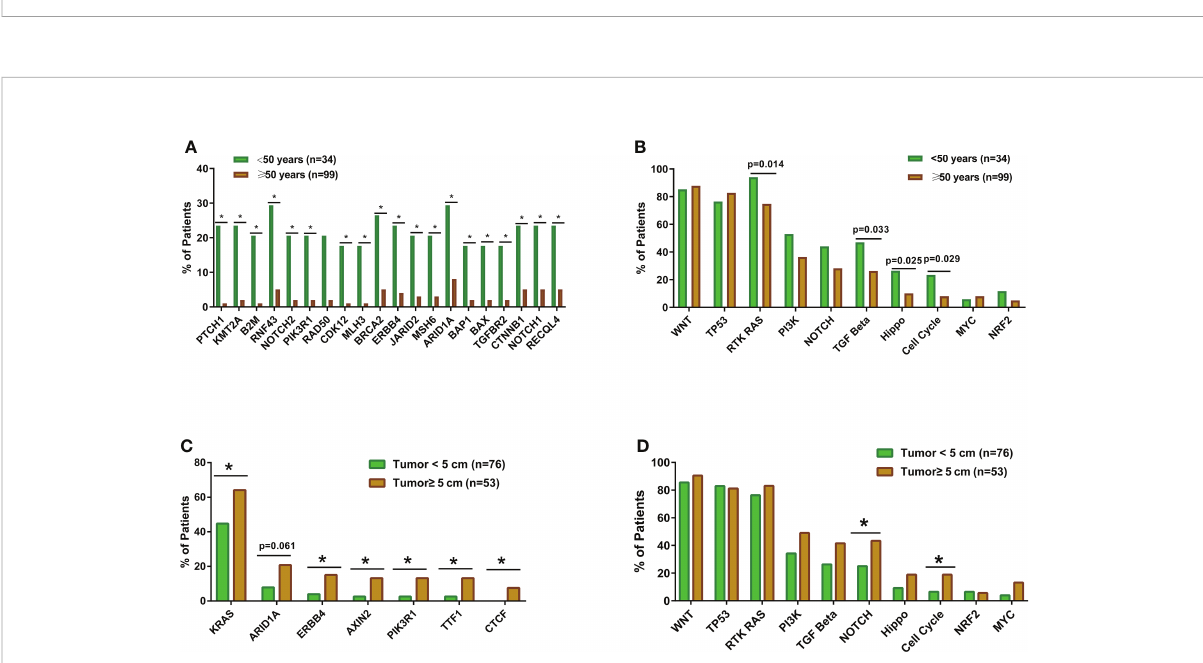
FIGURE 2 The comparisons of somatic mutation and pathway alteration characteristics between colorectal cancer patients with different tumor sizes and ages. (A) The bar plots comparing gene alteration rates in early-onset (N=34) and late-onset patients (N=99). (B) The bar plots comparing pathway alteration rates in early-onset (N=34) and late-onset patients (N=99). (C) The bar plots comparing gene alteration rates patients with small tumor size (tumor diameter smaller than 5cm, N=76) and large tumor size (tumor diameter equal or larger than 5cm, N=53). (D) The bar plots comparing pathway alteration rates patients with small tumor size (tumor diameter smaller than 5cm, N=76) and large tumor size (tumor diameter equal or larger than 5cm, N=53). *p <